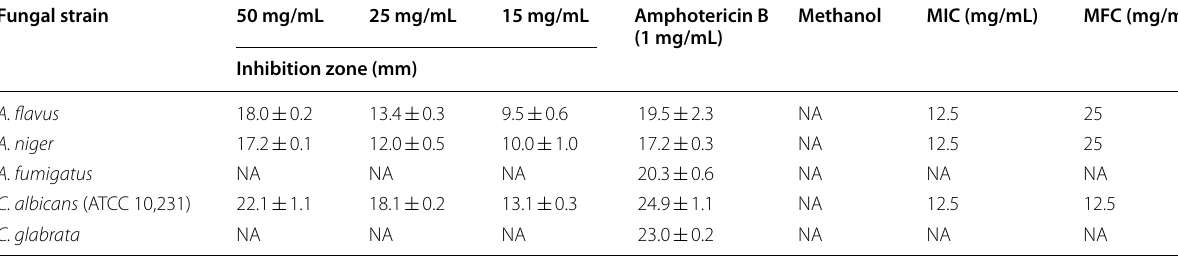
Amphotericin B: positive control, and methanol: negative control. NA no activity